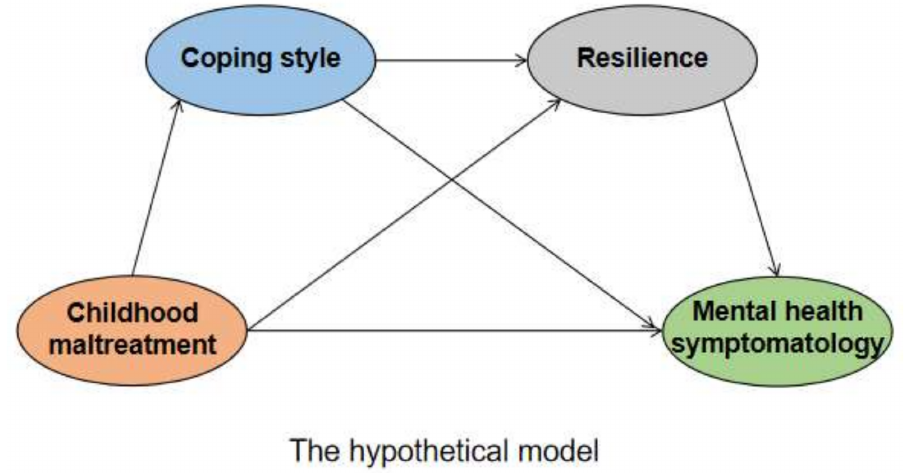
Figure 1. The hypothetical model: exploring the role of coping style and resilience between childhood maltreatment and mental health